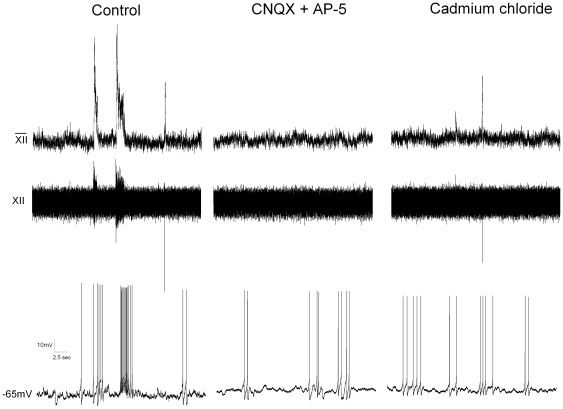
Firing in GABAergic pacemaker neurons is altered but not blocked by glutamatergic antagonists.GABAergic neurons fire bursts of action potentials during XII bursts. Cells were patch clamped in the current clamp configuration with a small amount of current (<30 pA) injected to hold the cell at −65 mV. Inspiratory activity was measured from the hypoglossal rootlets (top two traces). Fewer than half of these cells (n = 8/20) continued to fire in the presence of CNQX and AP-5. In cells that showed continued activity, the synaptic activity to these neurons, as well as voltage gated calcium channels, were blocked by addition of cadmium chloride. Pacemaker activity patterns changed but frequencies between the three groups was not significantly different (Control: 1.7+/−0.4 Hz; CNQX & AP5: 1.7+/−0.5 Hz; CdCl2: 1.8+/−0.6 Hz).